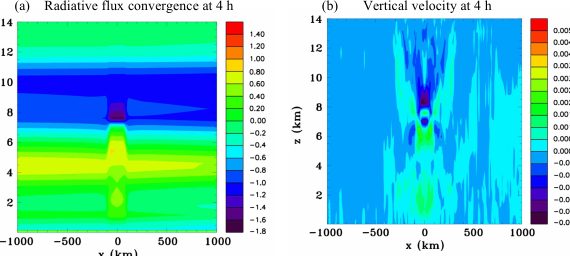
Figure 14. Vertical sections for Experiment 11: the radiation scheme activated in the whole domain with a mid-level vortex case. (a) Radiative flux convergence (Ks − 1 × 10 − 5 ), and (b) vertical ve- locity (ms − 1 ), at t = 4h, during the day.